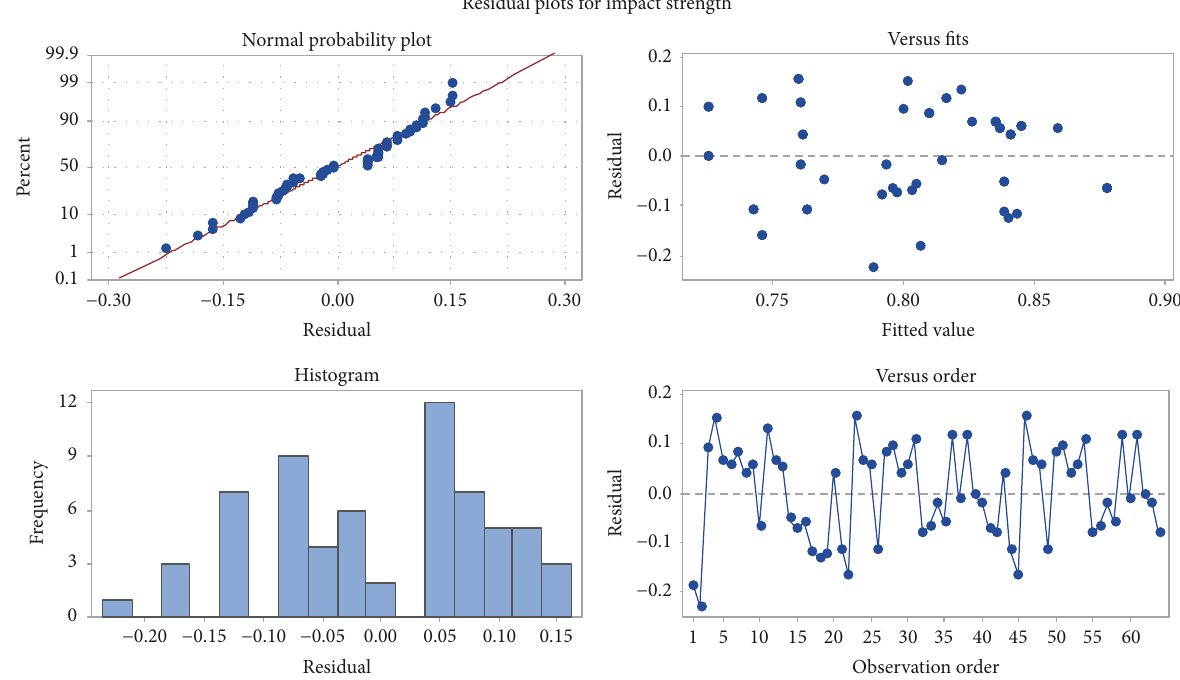
Figure 6: Residual plots of impact strength using linear regression